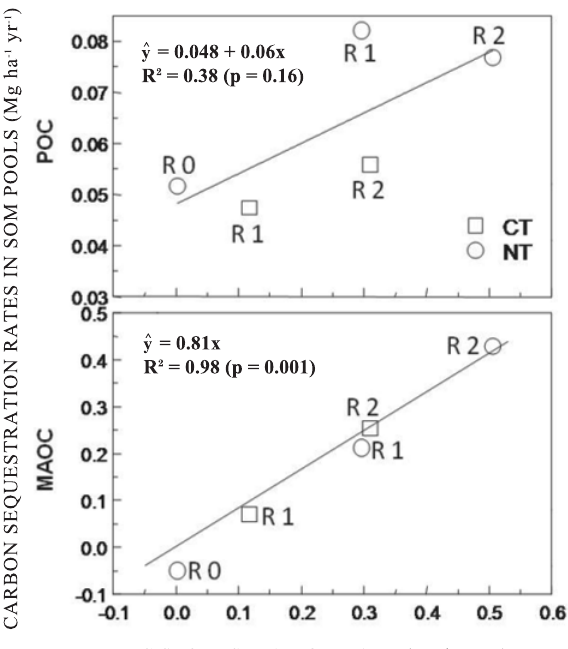
Figure 5. Annual carbon sequestration rates in whole soil (0–0.30 m) and in particulate organic carbon (POC) and mineral-associated organic carbon (MAOC) of a subtropical Oxisol under two tillage systems (conventional-CT and no- tillage-NT) under three crop rotations (R0=wheat/soybean; R1=wheat/soybean/ black oat/soybean; R2=black oat/soybean/black oat+common vetch/maize/oilseed radish/wheat/ soybean) using the traditional soil management system (CT R0) as control (baseline).